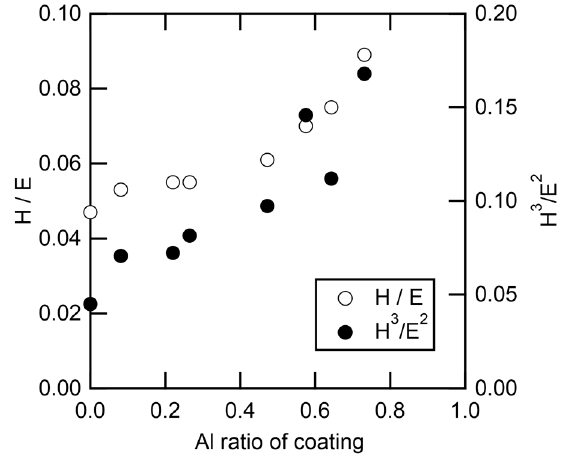
Figure 10. Relationship between Al ratio and H/E or H 3 /E 2 .